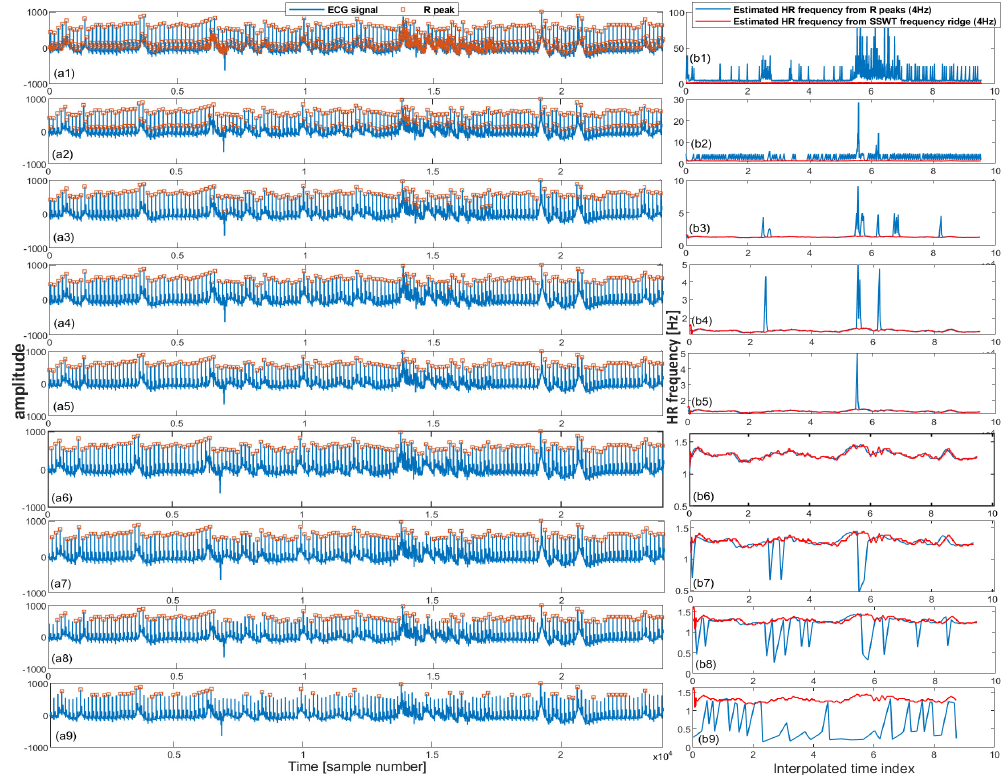
Figure 1. In each row, selected ECG segments and detected R peaks are shown on the left. In the right, the estimated HR frequency from the detected R peaks and synchrosqueezed wavelet transform (SSWT) are shown. The threshold to detect R peaks increases from top to bottom; ( b1 – b5 ) presents overestimated R peaks; ( b6 ) presents the correctly detected R peaks hugely overlapped with the estimated HR frequencies; ( b7 – b9 ) presents under estimated R